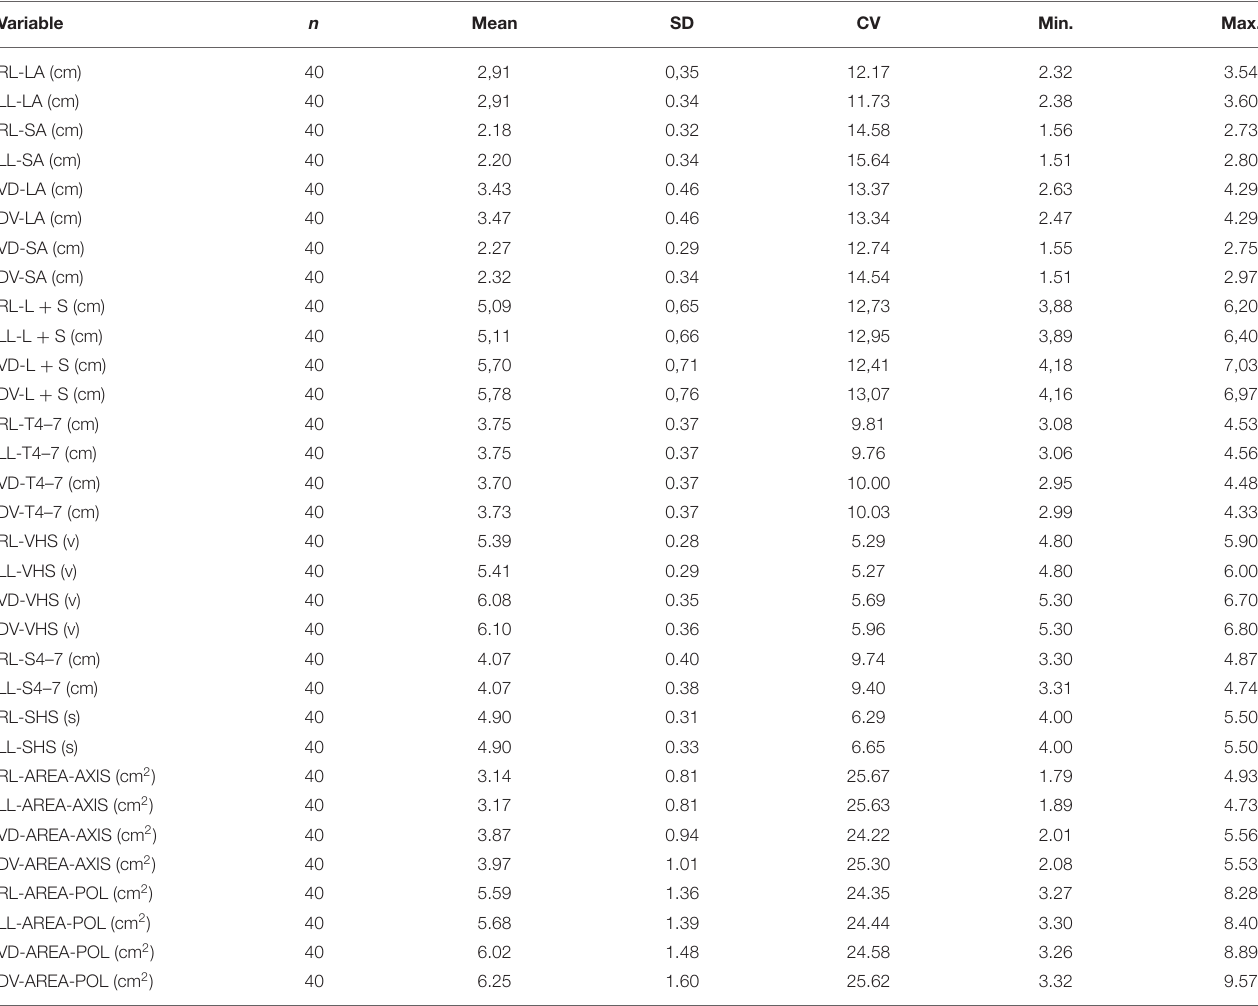
TABLE 1 | Radiographic measurements for the 40 healthy ferrets.